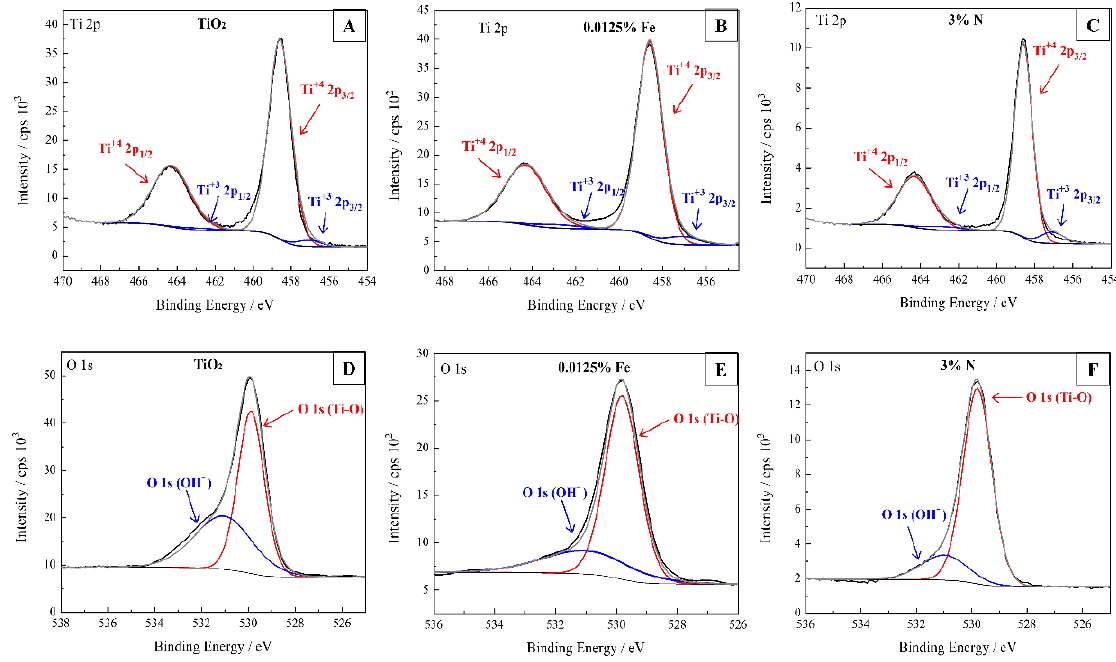
Figure 7. High-resolution XPS Ti 2p and O 1s spectra of TiO 2 ( A , D ), 0.0125% Fe ( B , E ) and 3% N ( C , F ). Table 2. Binding energies / eV and contribution of the high-resolution spectra of Ti 2p present in the photocatalysts. Values are obtained from high-resolution XPS spectra in Figure 6.